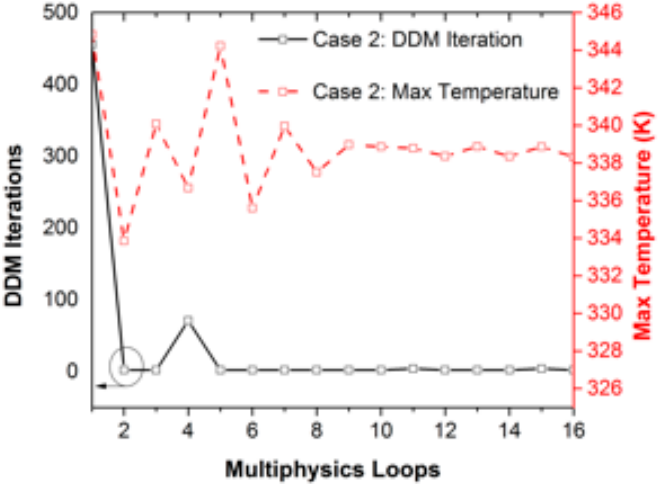
Figure 5. DDM iteration step change and maximum temperature change during multiphysics sim- ulation of case 1.